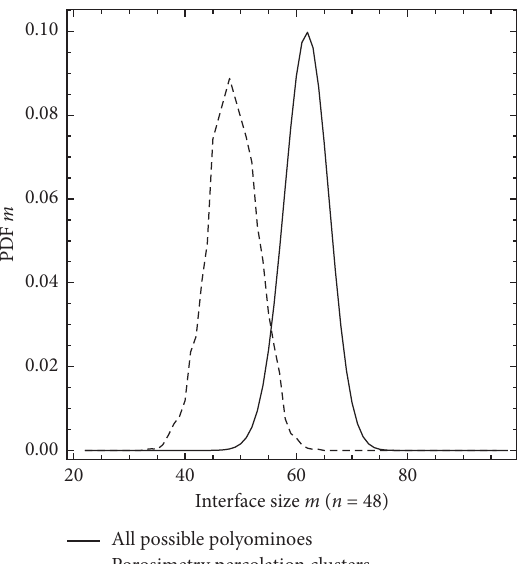
Figure 3: Probability density function of perimeters for all the possible polyominoes of size n � 48 and simulated percolation clusters having the same